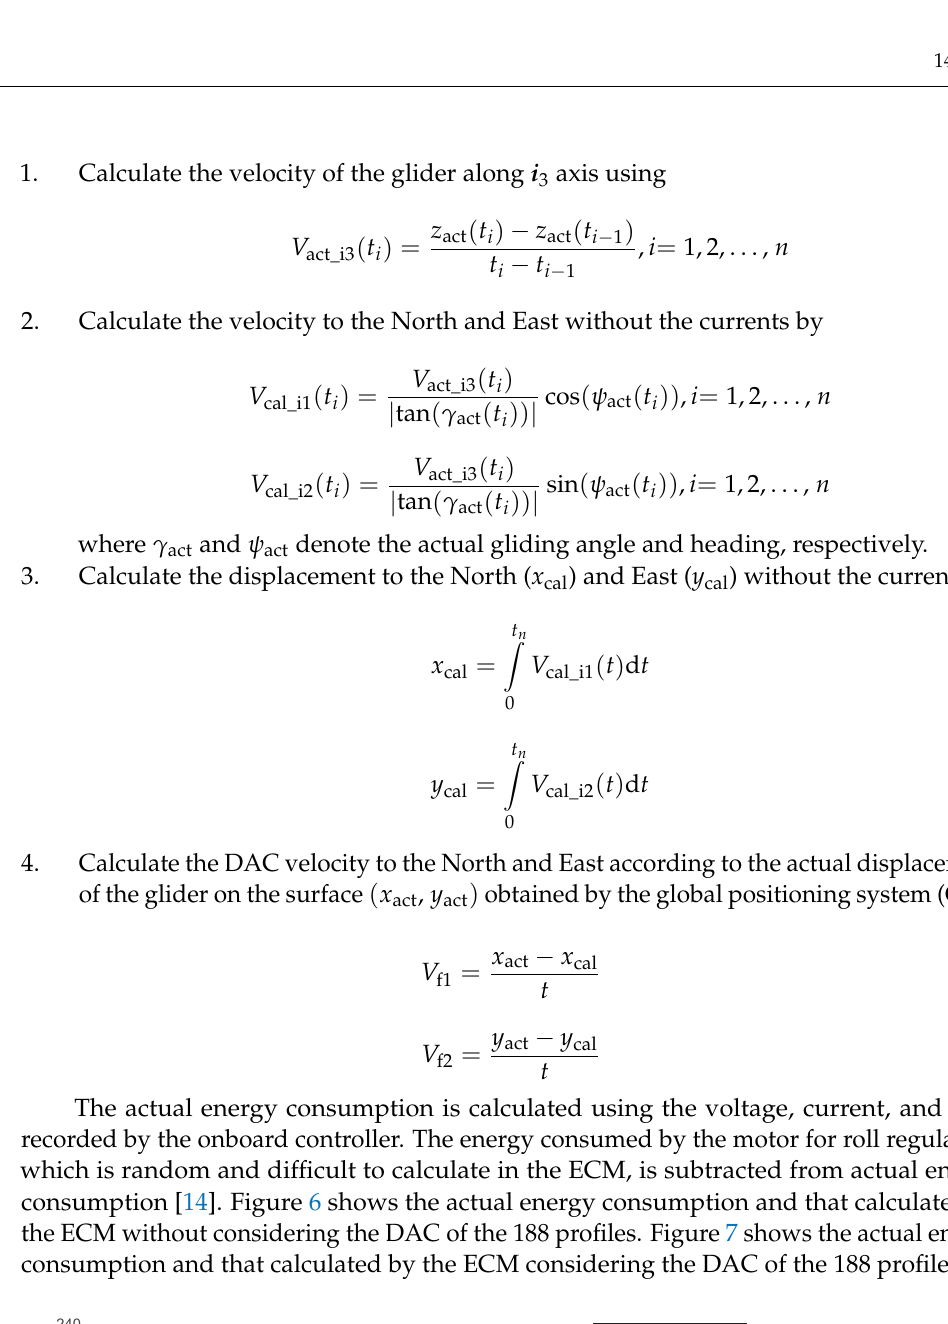
Figure 7. The actual energy consumption and energy consumption calculated by the ECM consid- ering the DAC. The mean absolute percentage error (MAPE) is employed to investigate the accuracy of the ECM. The MAPE of ECM without considering DAC is 47.58%, while that of ECM considering DAC is 14.45%, showing a difference of 33.13%, which indicates that the ocean currents have significant impact on the accuracy of the ECM. From Figures 6 and 7, we can find that the energy consumption calculated by the ECM is generally greater than the actual value. The main reason is that the final velocity, which is smaller than the average